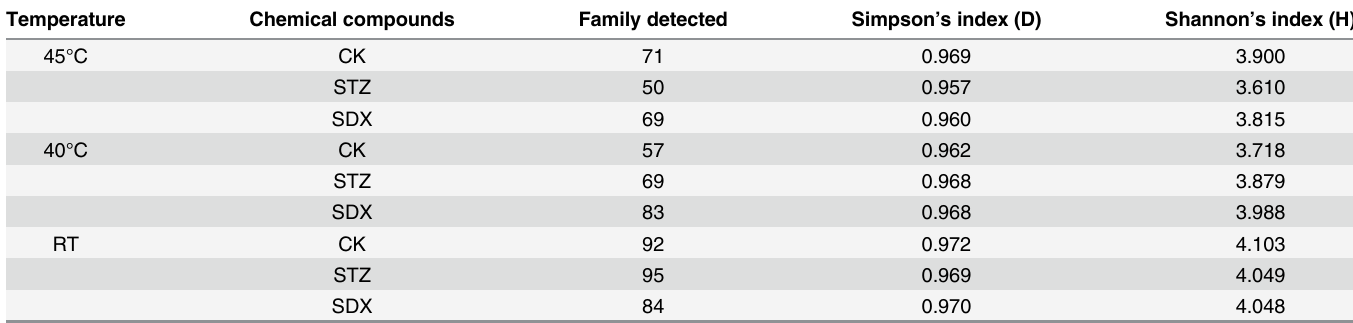
Table 2. Bacterial families detected and biodiversity indices in the HLB-affected citrus treated with thermo-chemotherapy.